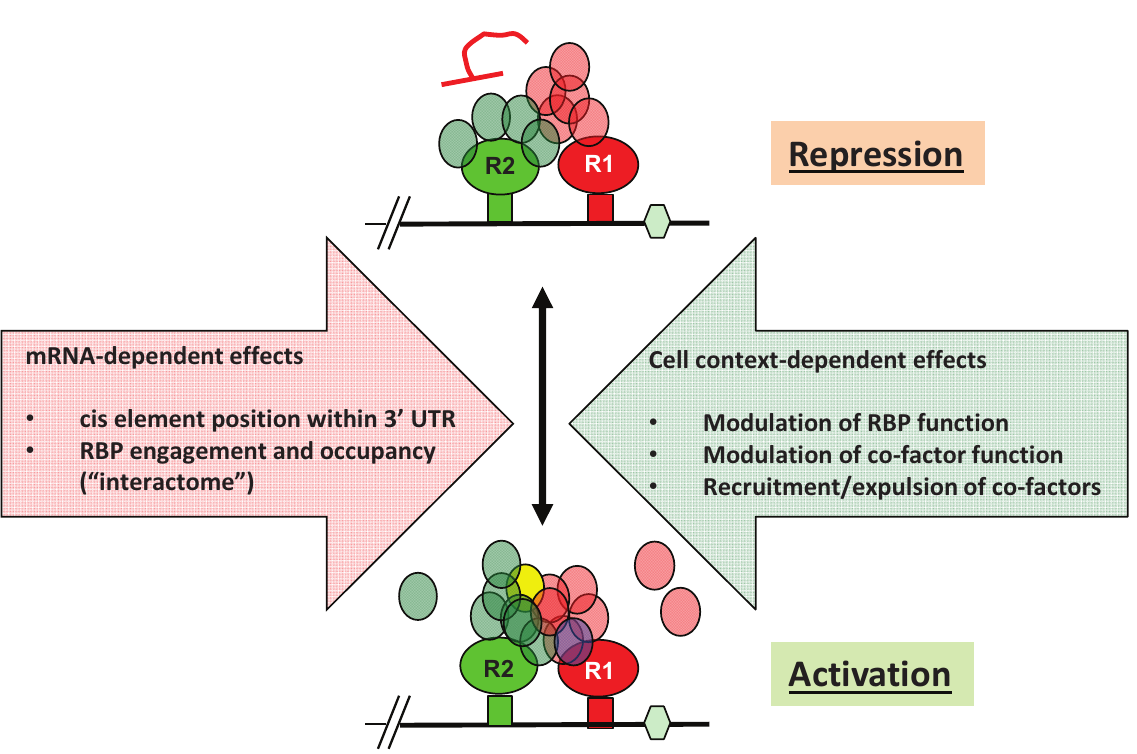
Figure 2. mRNA translational diplomacy—integration of multiple regulatory inputs. ( A ) When an mRNA is regulated by a single RBP (R1, large red oval) binding to its target site (red square), co-associated factors (small red ovals) mediate control of translation through interaction with 5' initiation factors, elongation factors, ribosomal constituents or 3' end processing factors as part of a higher order mRNP complex. In response to intrinsic or extrinsic cellular cues (Black arrow), remodeling of the mRNP occurs (e.g., recruitment of additional factors (yellow oval), expulsion of existing components (red oval), modification of existing component (blue oval)), resulting in altered control of translation. Hexagon, polyadenylation signal; ( B ) Control of mRNA translation often involves multiple distinct RBPs (R1 and R2, large red and red oval, respectively) interacting with the same target mRNA. When the RBPs exert similar function in any given cellular context, their activities lead to additive or synergistic regulation of translational output; ( C ) When the bound RBPs exert opposing functions, mRNA translational output reflects integration of conflicting RBP inputs. A combinatorial assembly of effector co-factors would permit recruitment, expulsion and/or modification of the higher order mRNP complex in response to changing cellular cues, resulting in mRNA-specific translational output. In this example the activity of a repressor RBP (R1, large red oval) and associated co-factors (small red ovals) overrides the activator function of a neighboring RBP (R2, large green oval) and its associated co-factors (small green ovals). However, modulation of R1 and/or R2 directly, modulation of co-factor function and/or association attenuates the ability of R1 to inhibit R2 activator activity. Interaction of the distinct RBPs (R1 and R2) thus results in mRNA- and cell context-dependent combinatorial assembly of recruited co-factors specific to the RBP